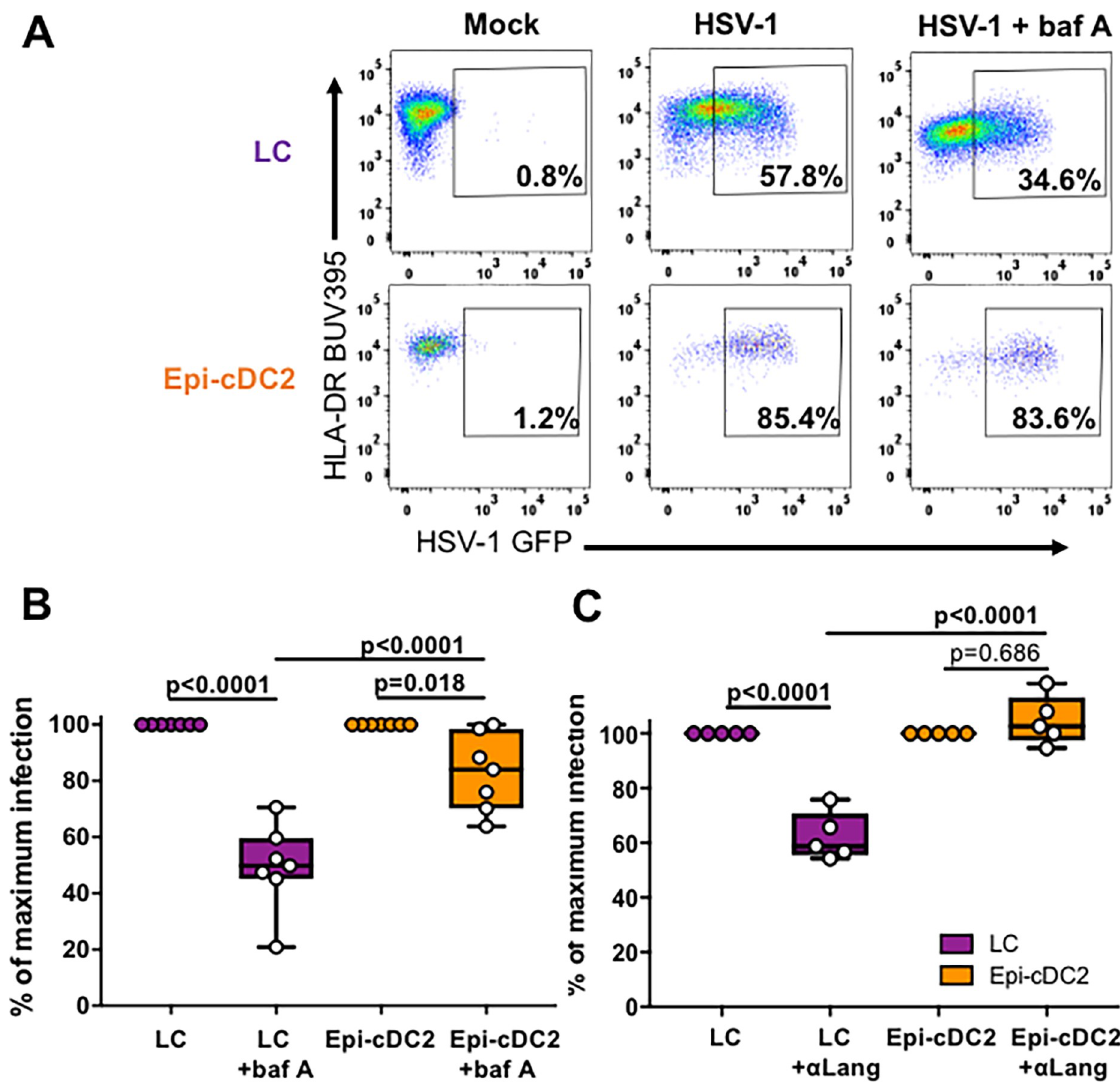
Fig 7. HSV-1 entry into LCs is pH-dependent and langerin-dependent. Isolated abdominal epidermal MNPs were pre-treated with 100 nM bafilomycin A (baf A) for 30 min at 37˚C (A and B) or with 5 μ g/mL anti-langerin antibody (C) then infected with HSV-1 GFP for 18 h and stained for flow cytometry as in Fig 2, to detect infection using GFP expression. (A) Representative plots of HSV-1 infection in the absence or presence of baf A. The percentage of HSV-1 GFP + cells was measured with and without (B) baf A (n = 7) or (C) anti-langerin antibody (n = 5) at 18 h. HSV-1 infected cells were set as 100% infection and the data are shown as box and whisker plots of the percentage of maximum infection in LCs (purple) and Epi-cDC2s (orange). Repeated measures one-way ANOVA with Tukey’s test for multiple pairwise comparisons was used to compare the percentage of maximum infection of each subset in the presence of